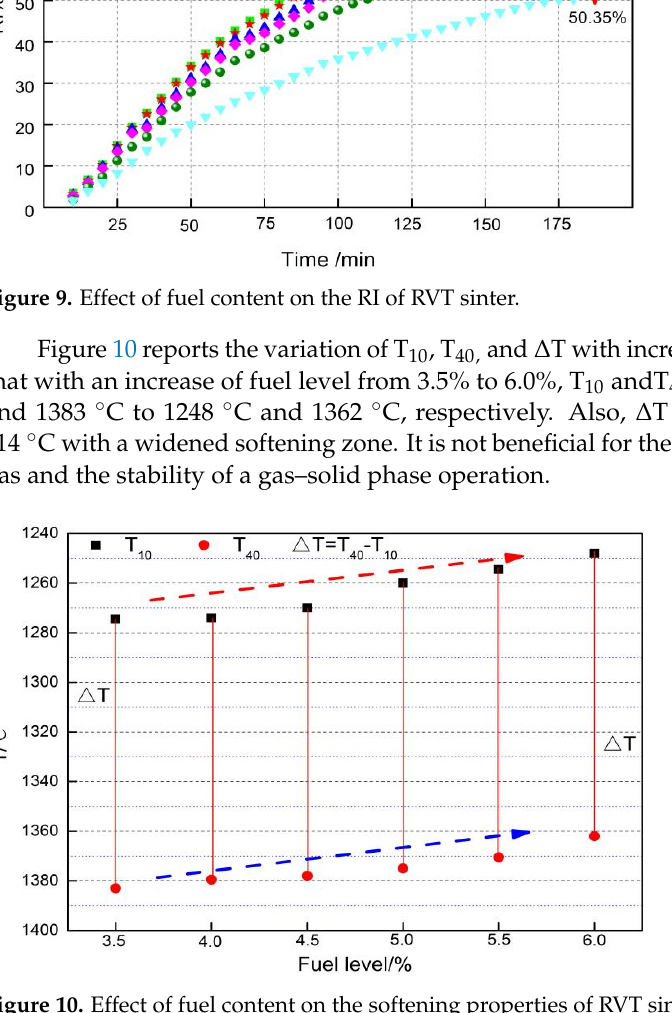
Figure 10. Effect of fuel content on the softening properties of RVT sinter.